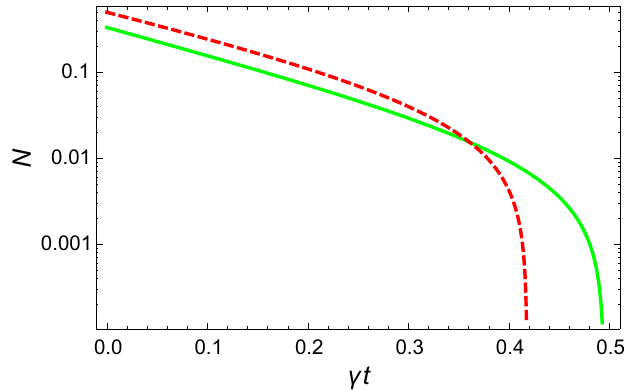
Figure 1: E ff ect of local depolarization and polarization de- pendent losses, Λ ( t ) ⊗ Λ ( t ) with γ H = γ and γ V = 5 γ , on two-qubit entanglement dynamics (negativity) for di ff erent ini- tial states: the maximally entangled one (red dashed line) and the optimal one (green solid